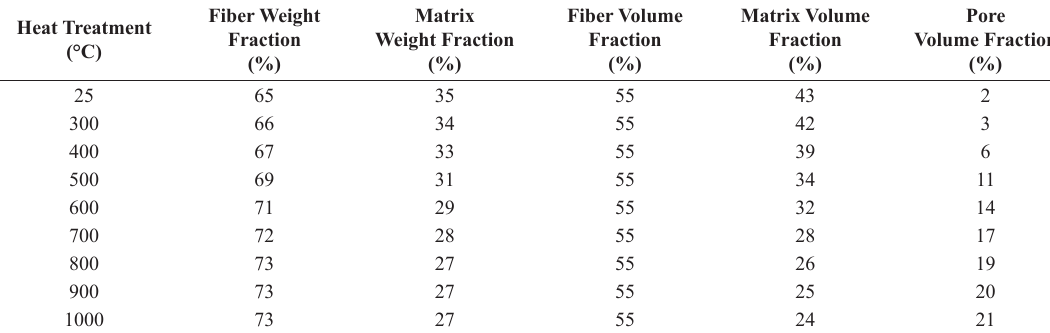
Table 1. Weight fraction and volume fraction of carbon fiber, matrix and